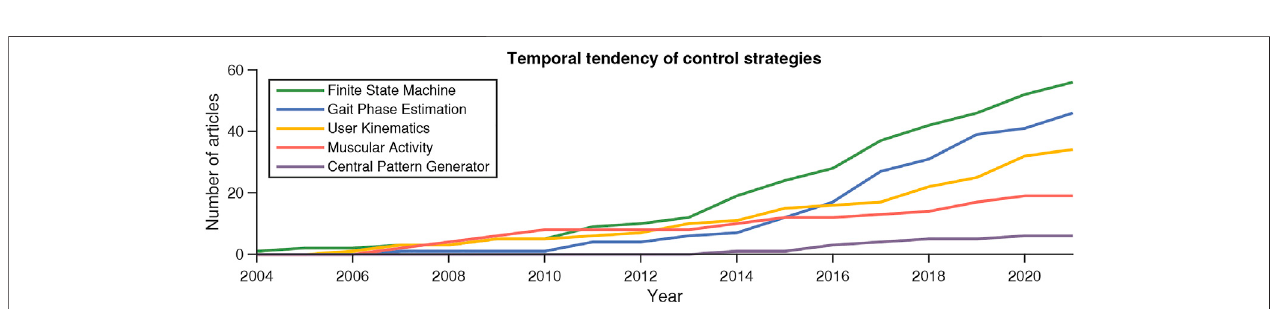
Frontiers in Bioengineering and Biotechnology |